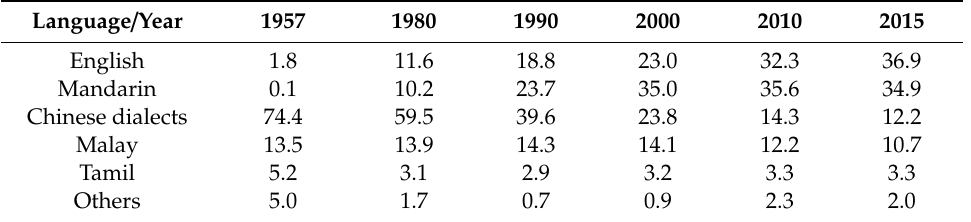
Table 1. Speakers of the main languages in Singapore based on “the language most frequently spoken at home” (%)